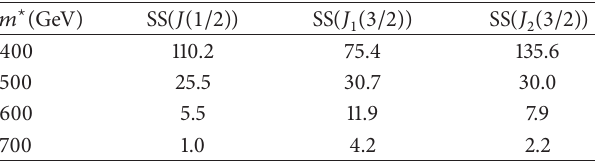
Table 4: Statistical significance SS for 𝑒𝑝 collider with √𝑠 = 1.3 TeV for excited spin-1/2 neutrinos and excited spin-3/2 neutrinos with 𝐽 1 and 𝐽 2 .